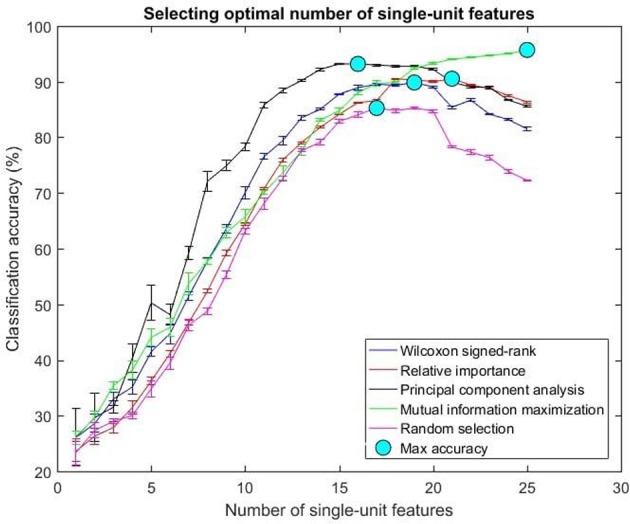
Selecting optimal number of single-units. The plot above shows the cross validated accuracy of feature selection algorithms for increasing number of single-unit features. The solid circle (cyan) in each graph shows the maximum cross-validated accuracy for a feature selection algorithm. The number of single or multi-unit features corresponding to this accuracy was chosen as the optimal number of features. The points and error bars correspond to the mean and standard error of maximum cross-validated accuracy respectively.